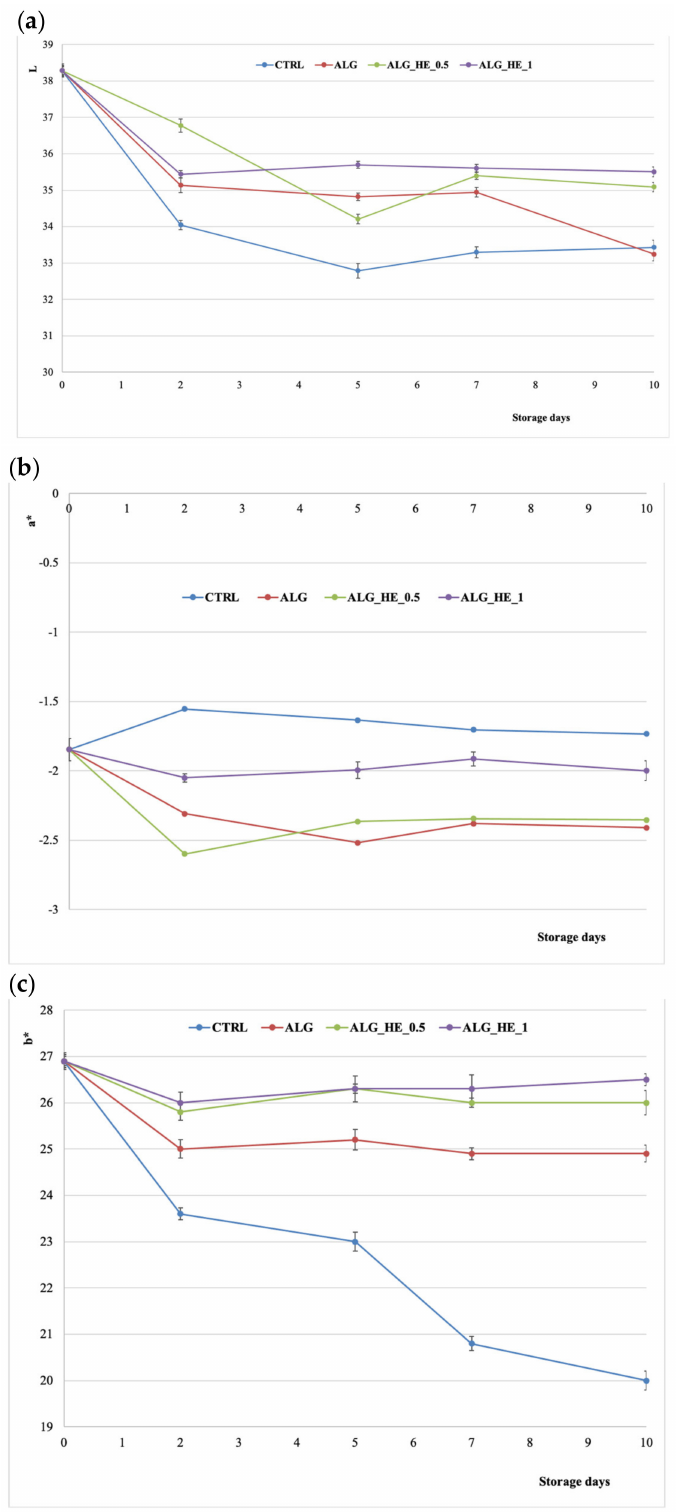
Figure 5. Changes in CIELAB coordinates (mean ± sd; n = 30 ) of fresh-cut kiwifruit underwent different treatments during storage at 4 ◦ C: ( a ) effect on L coordinate; ( b ) effect on a* coordinate; ( c ) effect on b* coordinate. CTRL, control samples; ALG, alginate samples; ALG_HE_0.5, samples coated with alginate added with 0.5% of hop extract; ALG_HE_1, samples coated with alginate added with 1% of hop